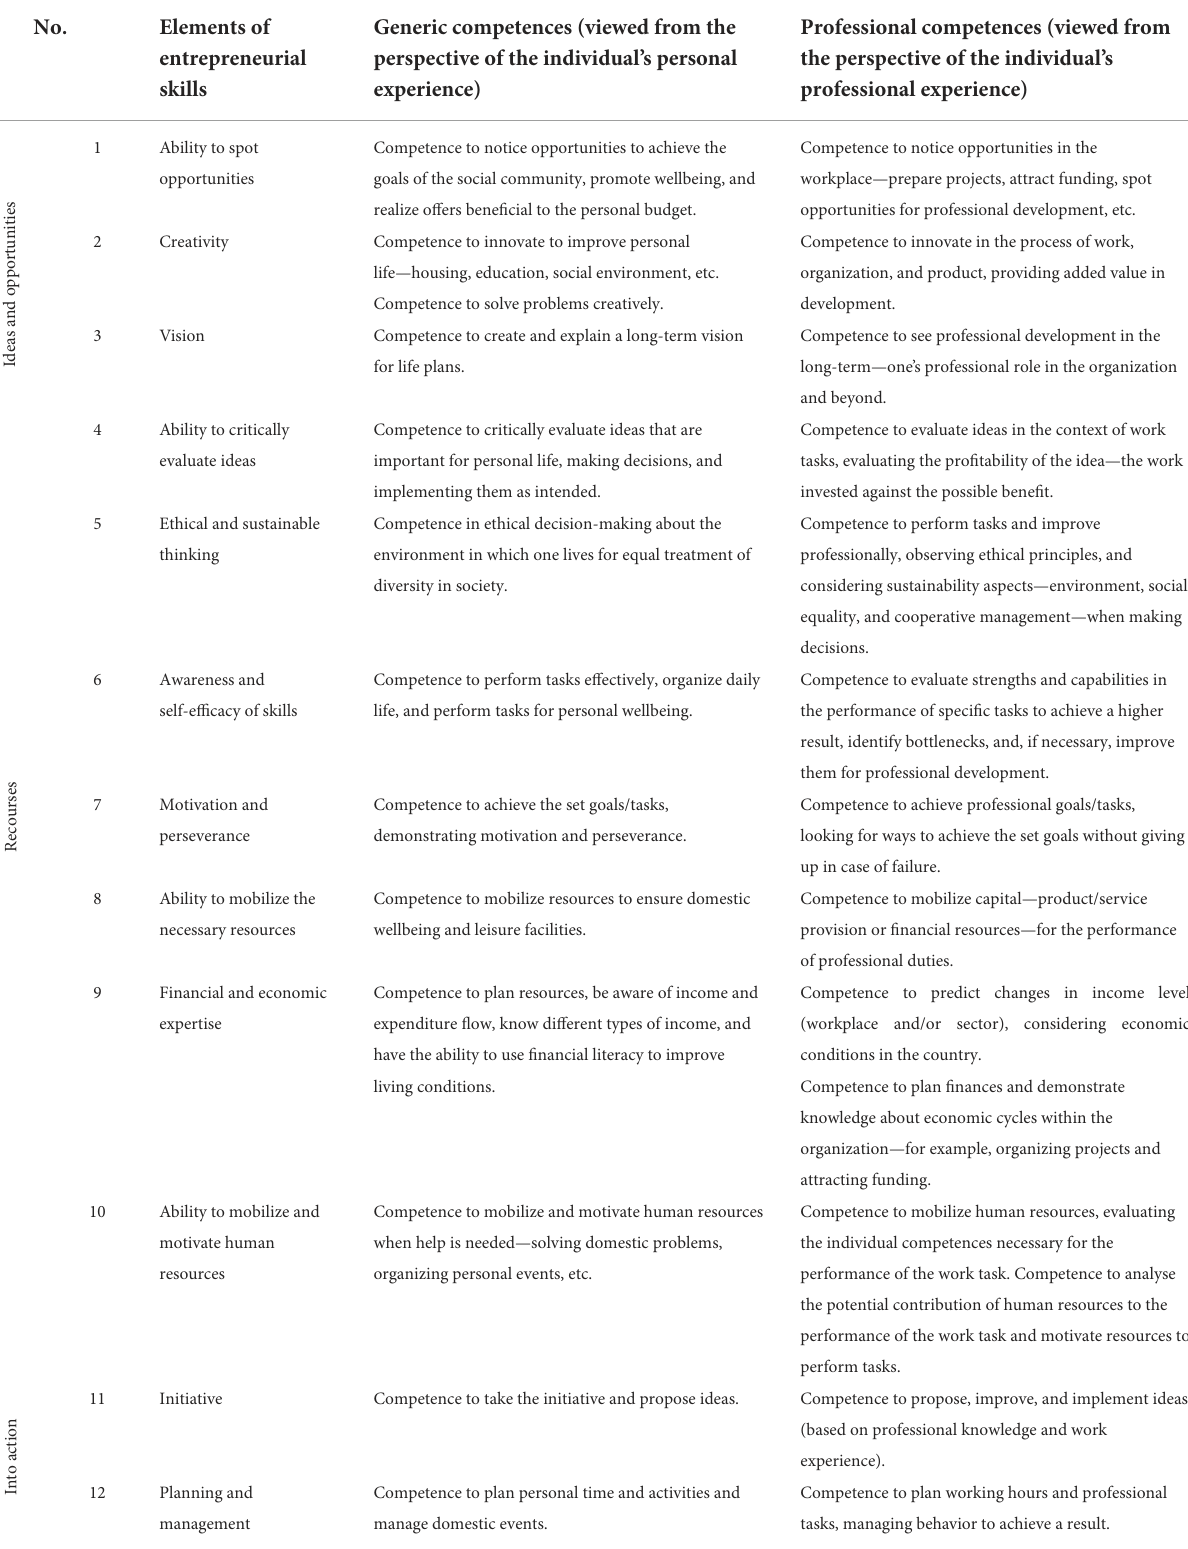
TABLE 1 Distinction—entrepreneurship as generic and professional